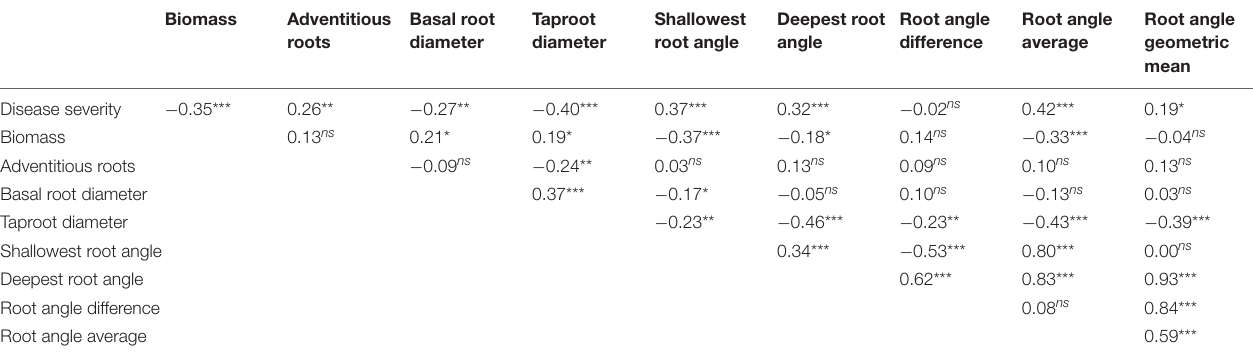
TABLE 4 | Pearson multiple correlation coefficients 1 for Least Square Means of the BeanCAP Snap Bean Diversity Panel evaluated for Fusarium solani disease and plant and root traits at the Oregon State University Vegetable Research Farm near Corvallis in 2014 and 2015. Biomass Adventitious Basal root Taproot Shallowest Deepest root roots diameter diameter root angle